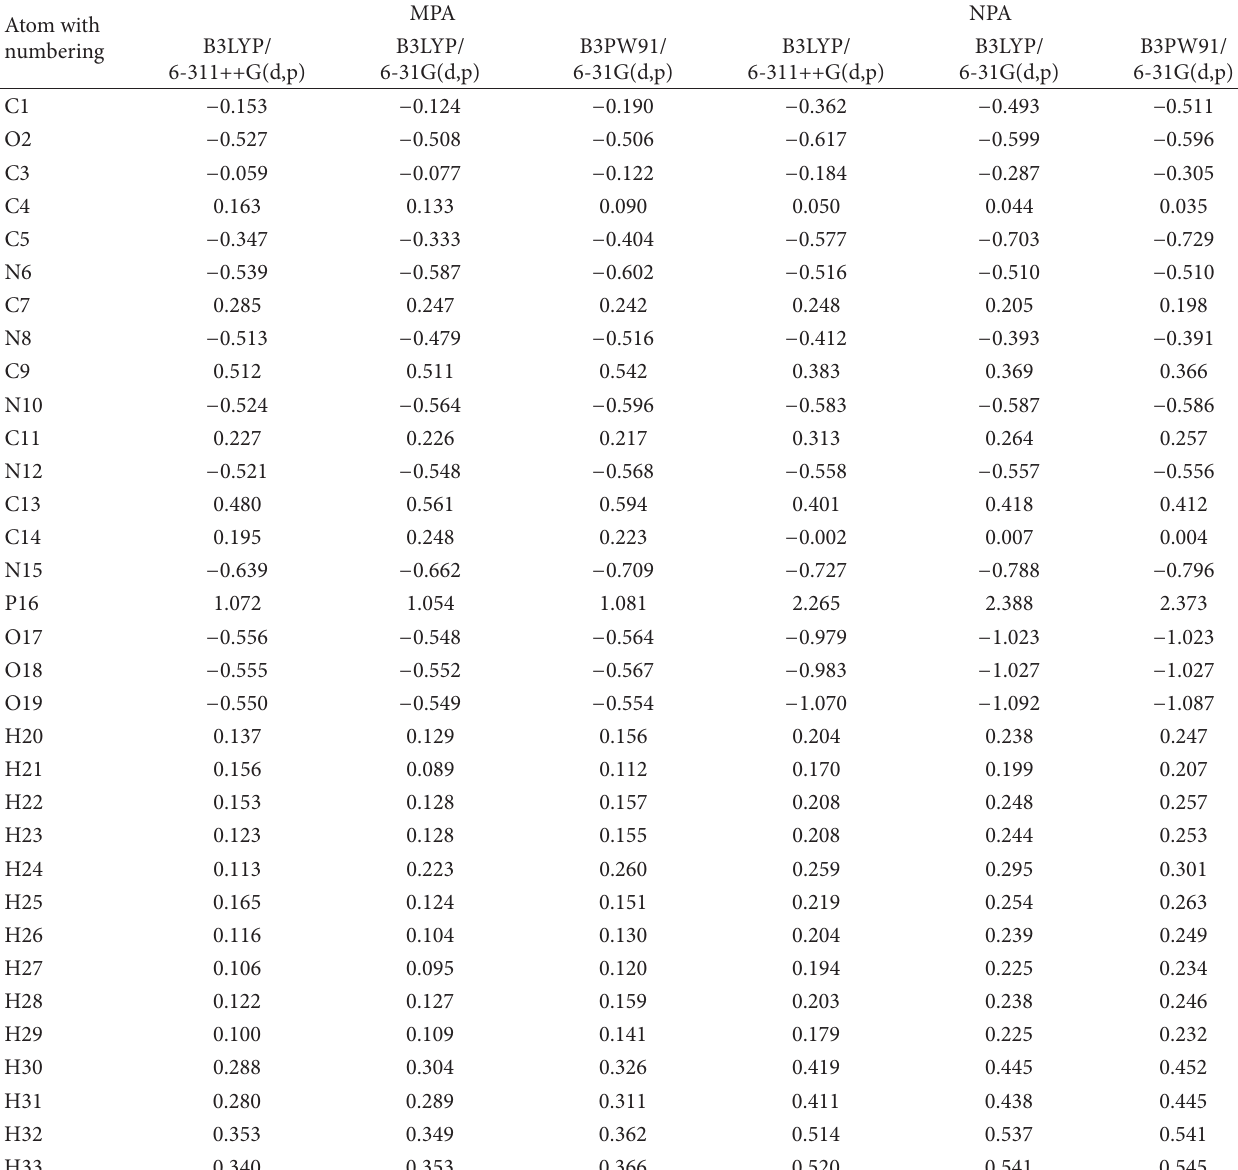
T 4: Natural atomic charges of